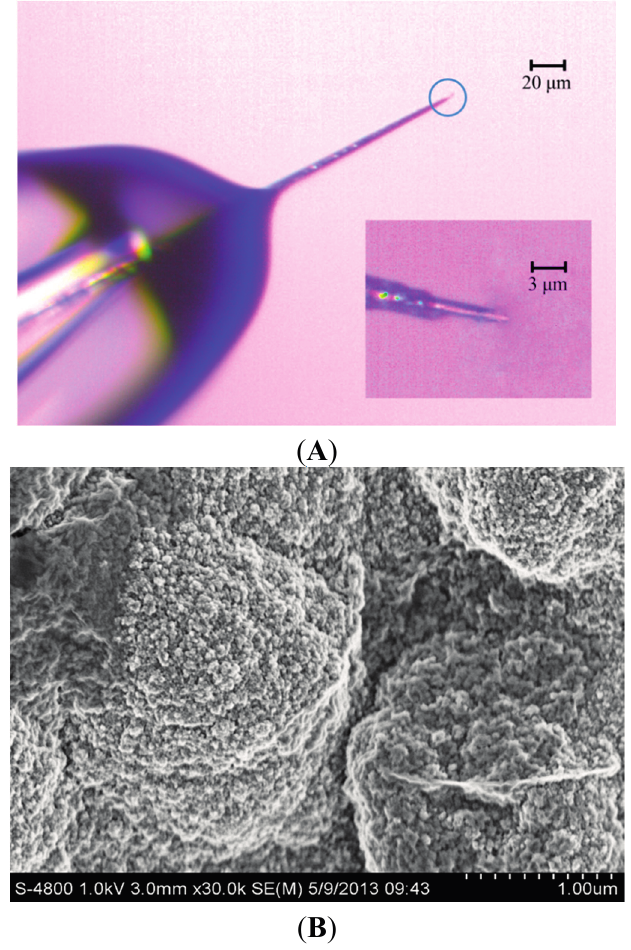
Figure 1. ( A ) The fabricated CFE with diameter of 2 µm; the inset shows interface between carbon fiber and the glass insulator; ( B ) The SEM at the cycle of 8.